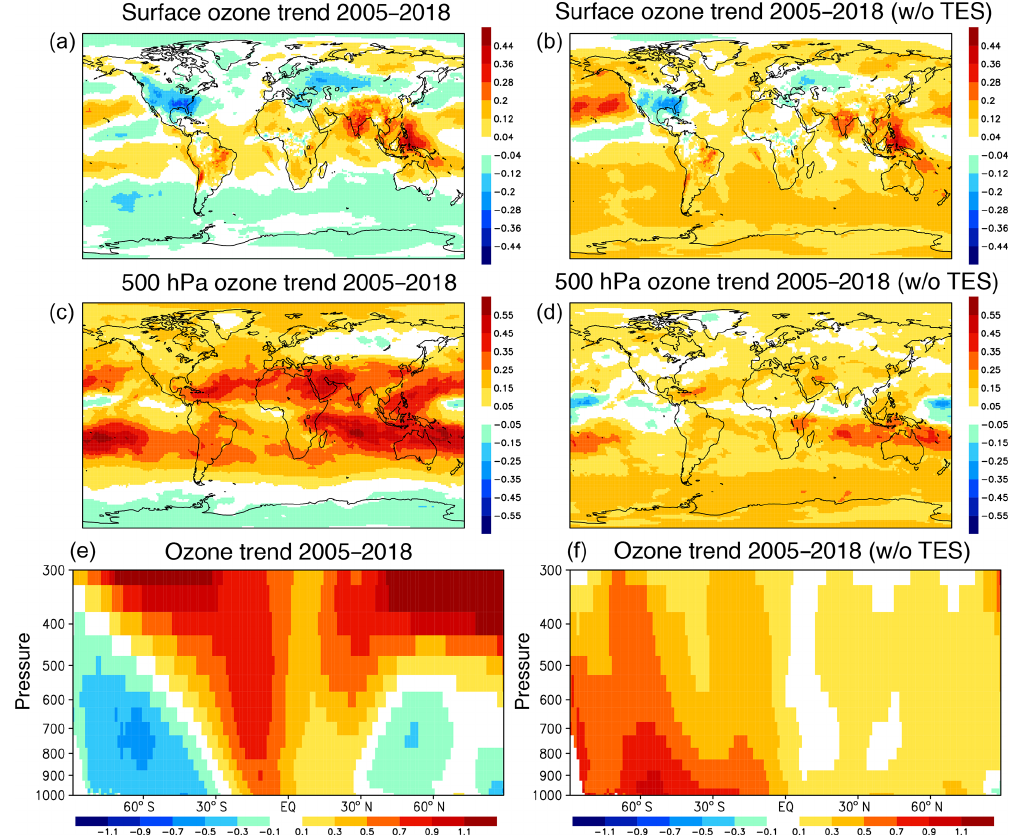
Figure 16. Global distribution of linear trend of ozone concentrations (in parts per billion per year) at the surface (a, b) and 500hPa (c, d) obtained from the reanalysis (a, c, e) and noTES reanalysis (b, d, f) for the years 2005–2018. Panels (e) and (f) show latitude–pressure cross sections of the linear trend (in % per